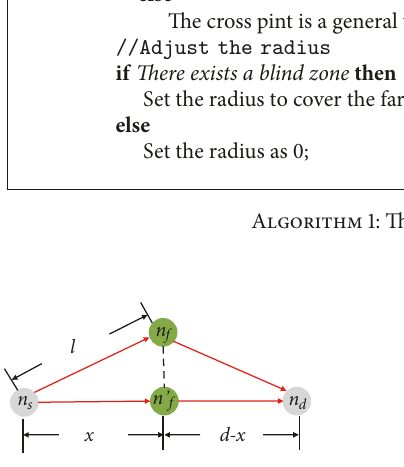
Figure 6: Transmitting the data from node 𝑛 𝑠 to 𝑛 𝑑 via node 𝑛 𝑓 and 𝑛 󸀠 𝑓